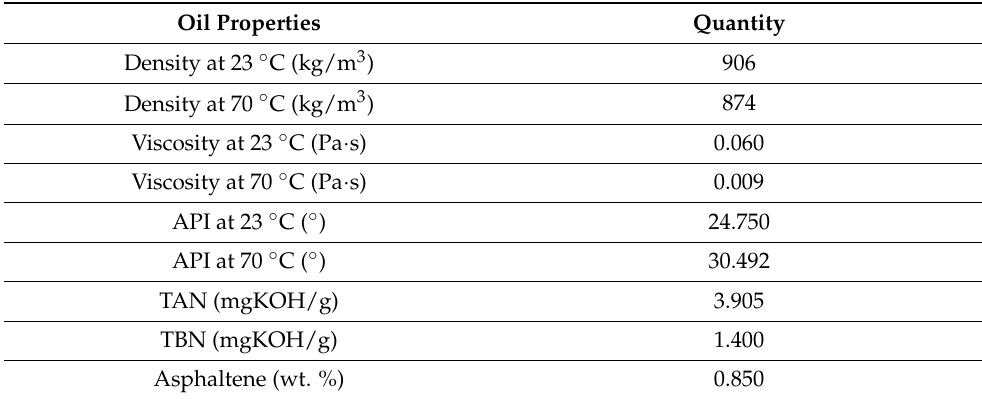
Table 2. Crude oil properties. Here: API is the American Petroleum Institute gravity. Oil